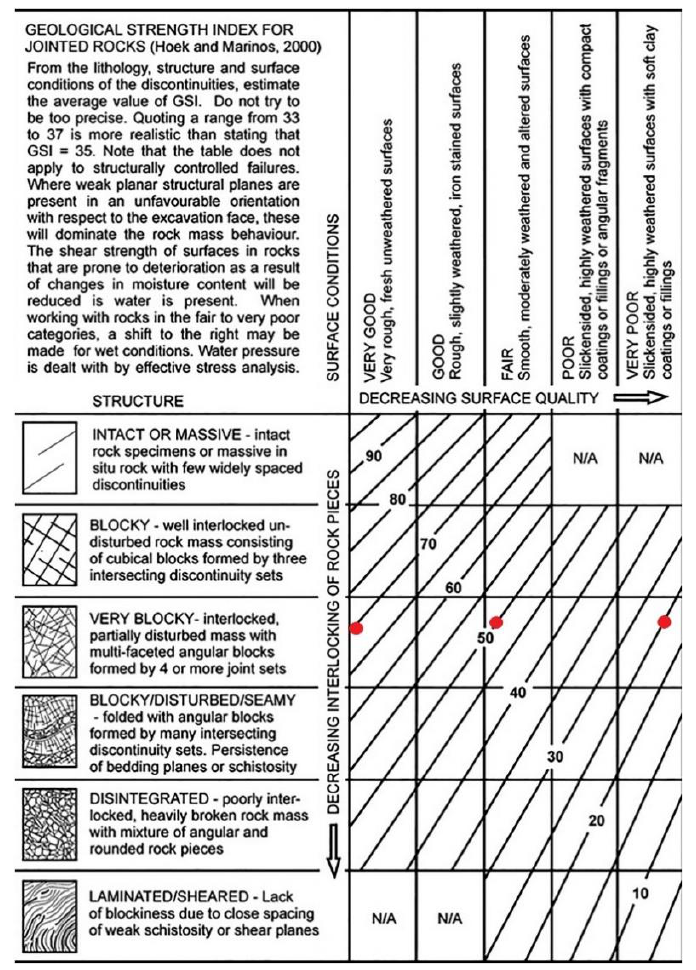
Figure 4. Basic geological strength index (GSI) chart for the visual geological characterization of rock masses. Red dots indicate the selected GSI values in the very blocky structure category used in this paper. From Marinos & Hoek [16].